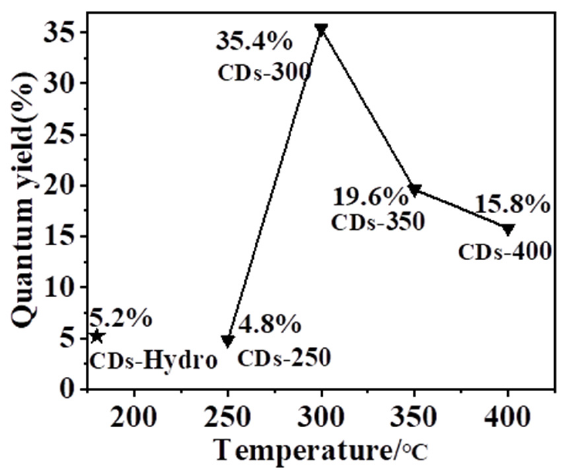
Figure 4. Dotted line plot of CDs quantum yield versus reaction temperature.